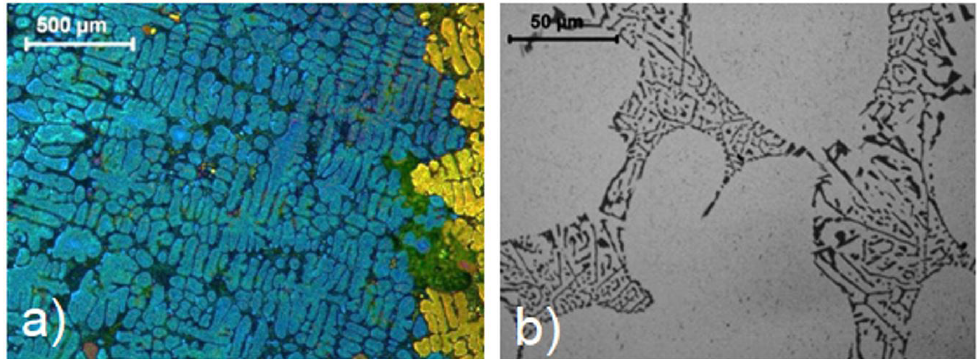
Figure 1. Optical micrographs of the as-received A356 alloy. (a) Polarized-light image micrograph highlighting the Al-rich dendritic grains; (b) BF image highlighting the Si-rich eutectic interdendritic (dark needles) and Al